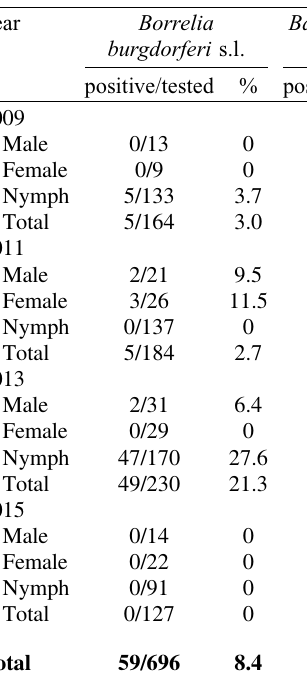
Table 2. The results of PCR assays for the different tested pathogens with the corresponding